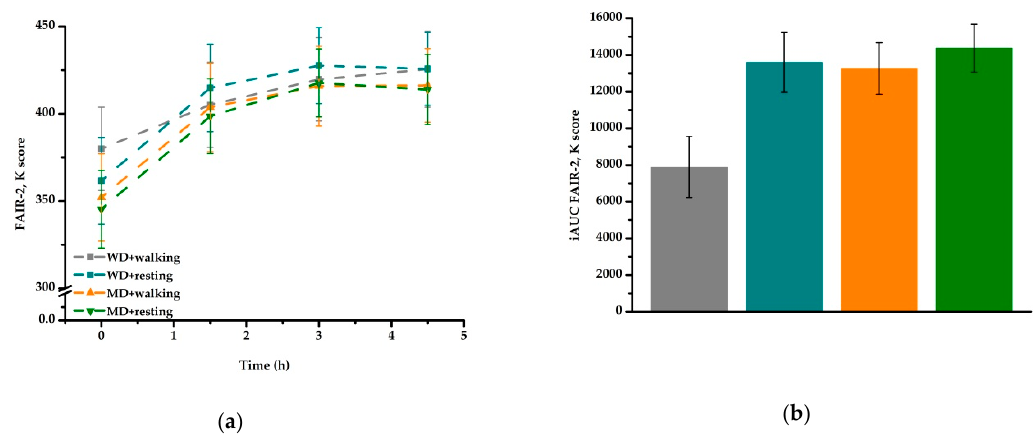
Figure 1. Fasting and postprandial attention (FAIR-2, K score) according to treatment condition: ( a ) K score over time: the overall test performance increased over time ( P < 0.001). A significant interaction for meal × activity ( P = 0.026) was observed: for WD but not MD, values were lower after walking compared to resting ( P < 0.001) ( b ) iAUC of K score: data revealed an effect of meal type ( P = 0.045) and activity ( P = 0.027). FAIR-2, Frankfurt Attention Inventory 2; iAUC, incremental area under the curve; MD, Mediterranean-type diet meal; WD, Western diet high-fat meal.